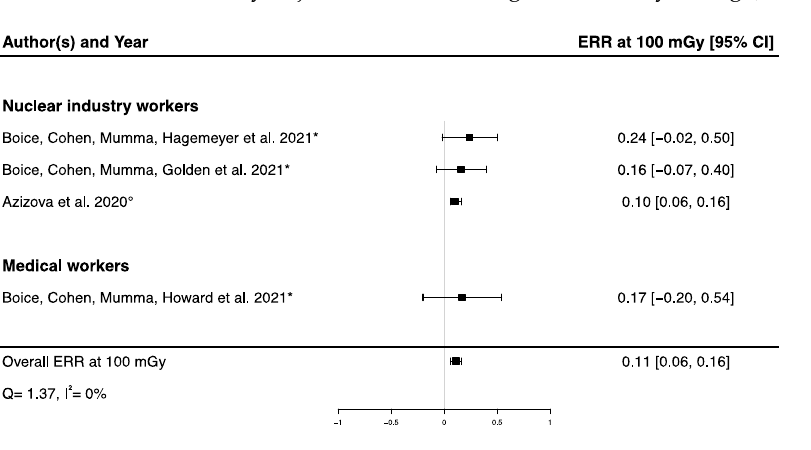
Figure 5. Excess relative risk (ERR) at 100 mGy and 95% confidence interval (CI) for morbidity and mortality from Parkinson’s disease in relation to IR exposure (° incidence; * mortality).